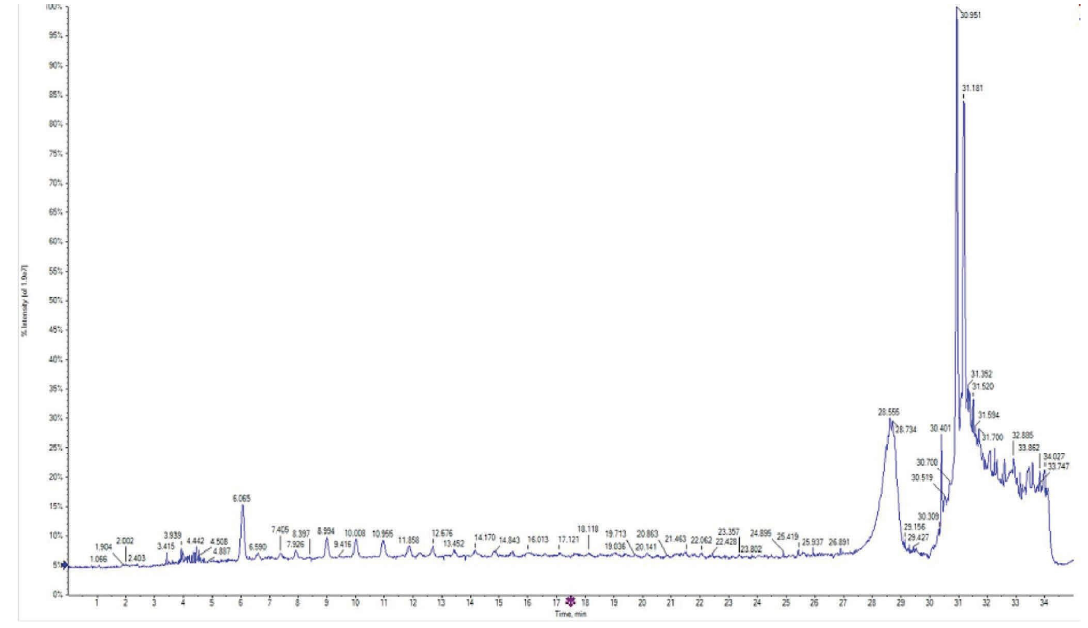
Figure 7: LC-MS/ESI-MS spectra of purifed protein of D. stramonium . Table 5: Peptide mass fngerprinting subunit analysis of purifed protein of D. stramonium